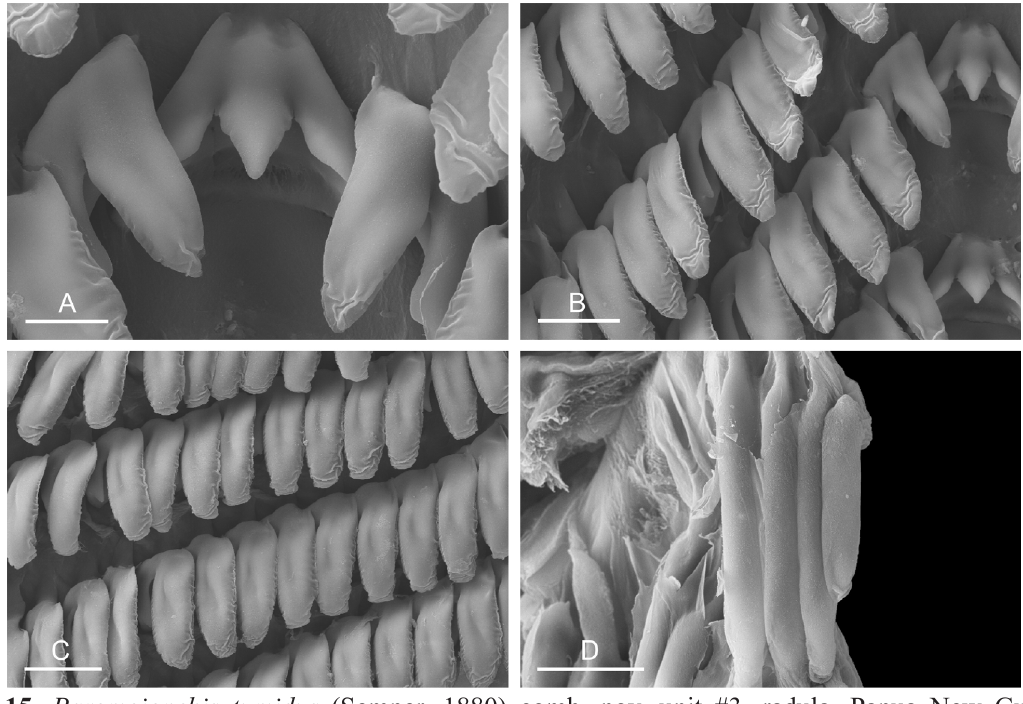
Fig. 15. Paromoionchis tumidus (Semper, 1880) comb. nov. unit #3 , radula, Papua New Guinea, Madang. A . Rachidian and innermost lateral teeth, [5432] (MNHN IM-2013-10478). B . Lateral teeth with rachidian teeth, same as A. C . Lateral teeth, same as A. D . Outermost lateral teeth, [5433] (MNHN IM-2013-10479). Scales: A = 10 μm; B, D = 20 μm; C = 25